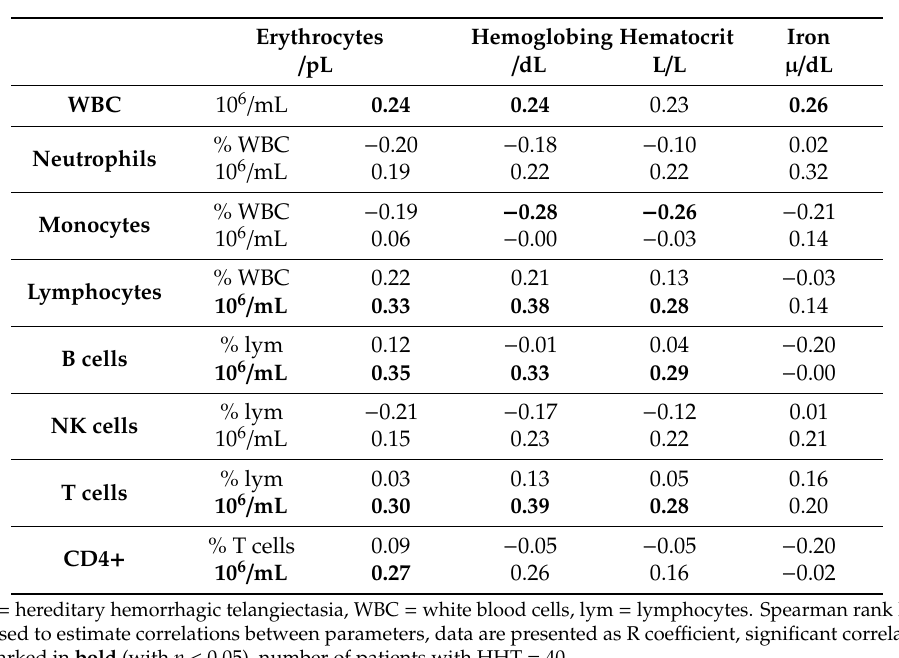
Table 3. Correlation of immune cell counts with red blood parameters in HHT.